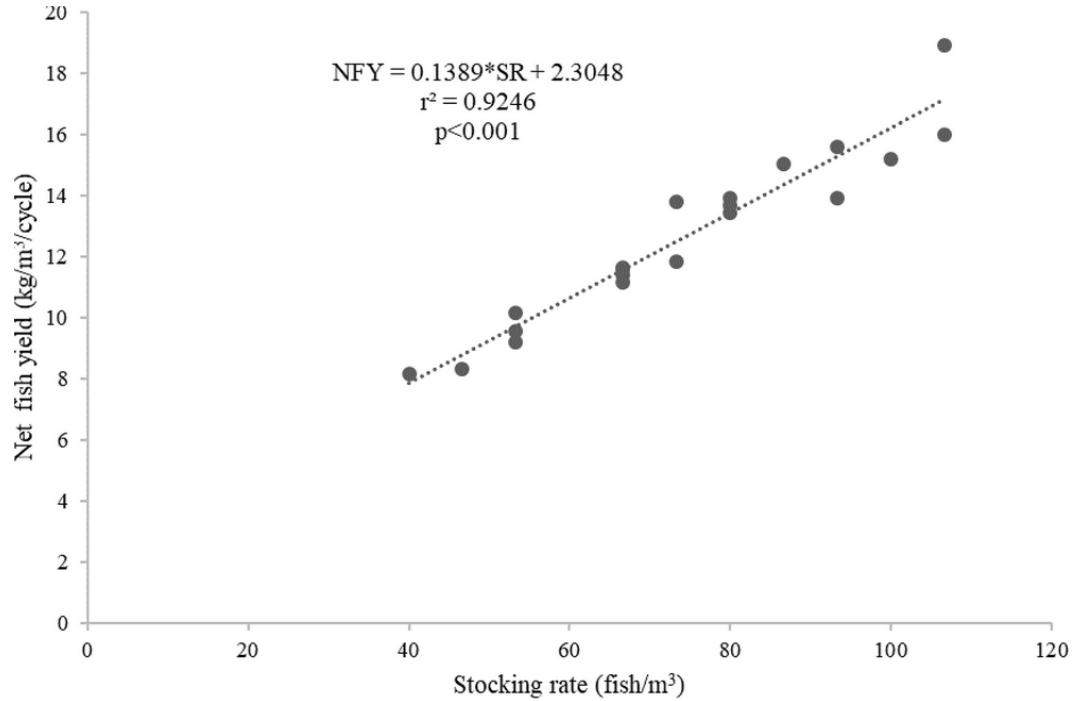
Figure 6. Stocking rates and net fish yield (kg/m 3 /cycle) relationship for giant gourami reared in floating cages.